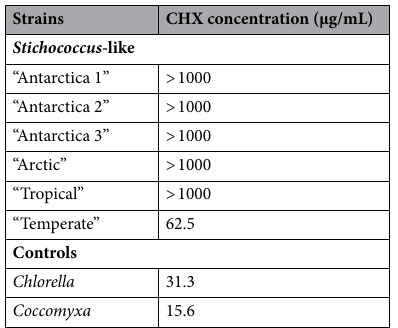
Table 1. Minimum inhibitory concentrations (MIC) of cycloheximide for each of six strains of Stichococcus - like algae and two control green algal strains assessed by visual observation on Day 14 of growth in